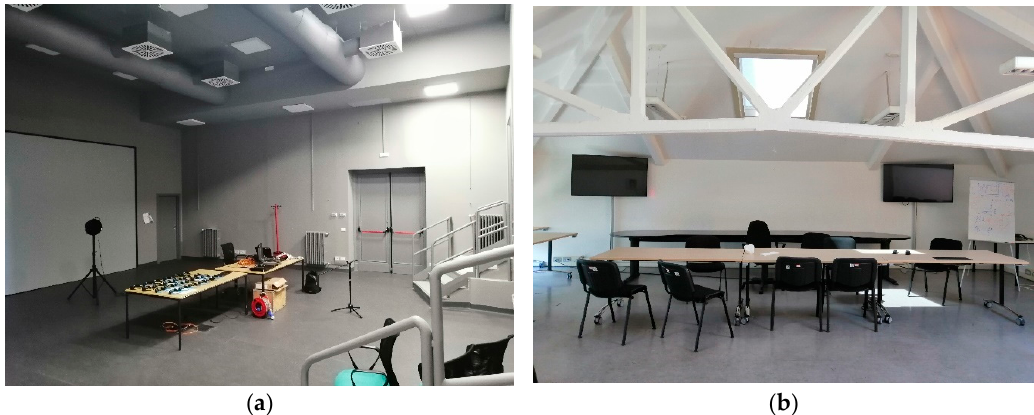
Figure 1. Photo of the two meeting rooms: ( a ) meeting room 1, view from a corner; ( b ) meeting room 2, view from the entrance.